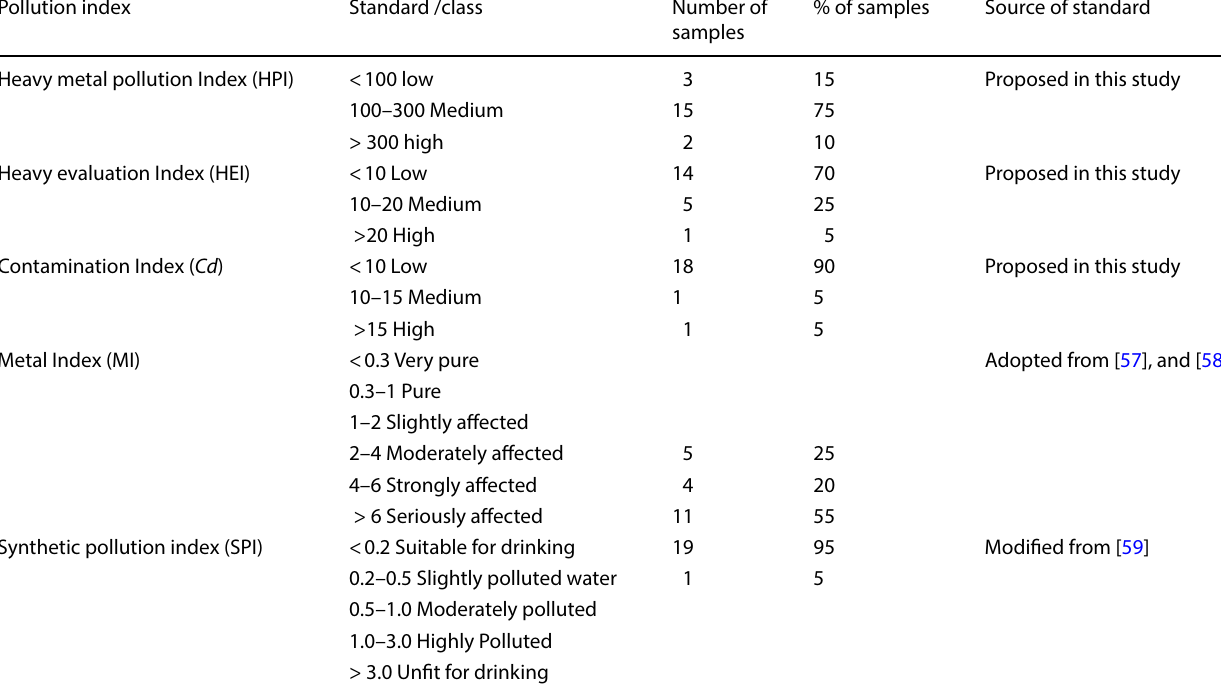
Table 4 Standards used for computed heavy metals indices and percentage of samples in each